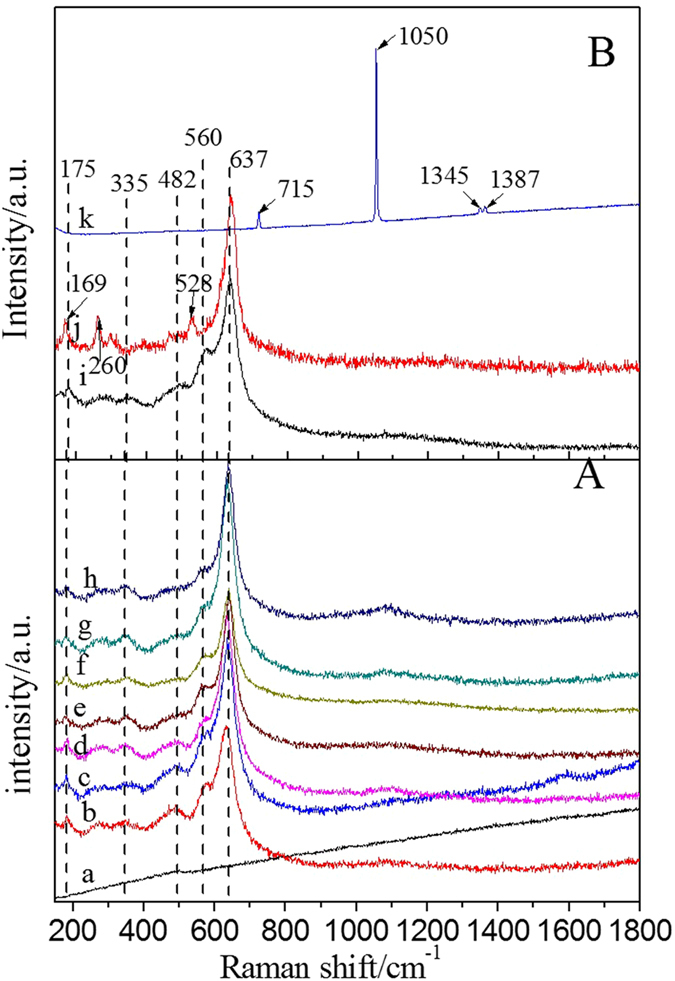
Raman spectra of as-prepared catalysts.(A) K-OMS-2/SiO2 obtained at varied K-OMS-2 loadings: SiO2 (a), K-OMS-2/SiO2-10 (b), K-OMS-2/SiO2-20 (c), K-OMS-2/SiO2-30 (d), K-OMS-2/SiO2-40 (e), K-OMS-2/SiO2-50 (f), K-OMS-2/SiO2-60 (g) and K-OMS-2/SiO2-70 (h) (B) different support and active components on the 3DOMSiO2: K-OMS-2/silica gel-50 (i), MnOx/SiO2-50 (j) and KNO3/SiO2-50 (k).